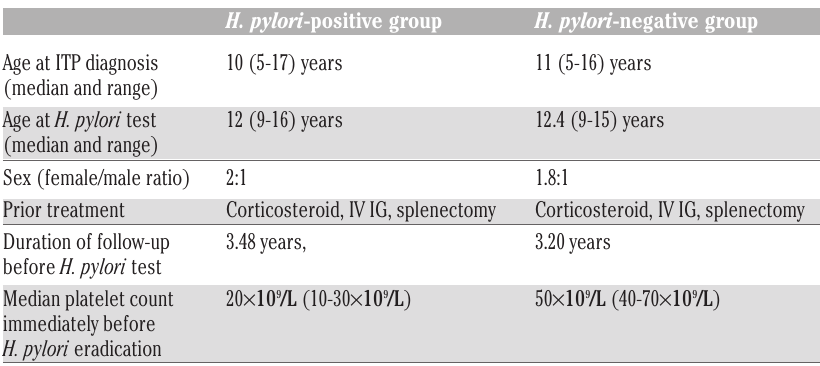
Table 1. Clinical and demographic characteristics in the H. pylori -positive and negative group before eradication.